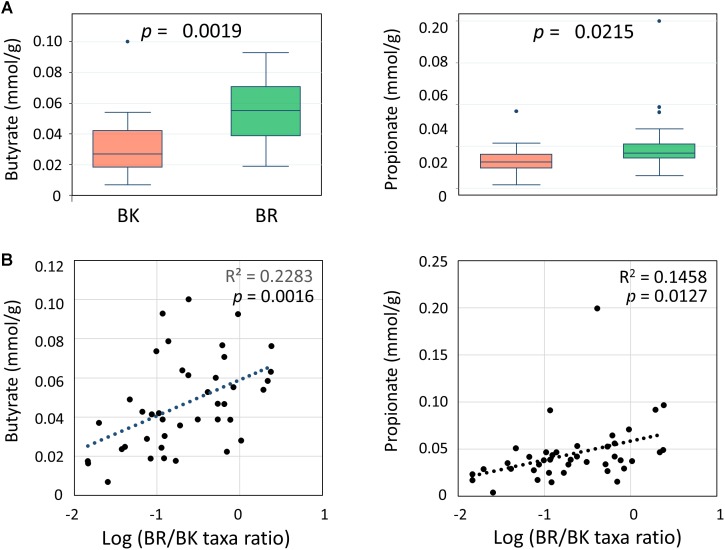
Comparison of the concentrations of fecal SCFAs between children in Bangkok and Buriram (A) and correlations with gut bacterial composition (B). The probability value (p) was calculated by Wilcoxon rank-sum test. Refer to Figure 1D for a description of the box plot. Correlation statistics were determined by Pearson’s correlation test. The post hoc analysis indicated the statistical powers for these Pearson’s correlation analyses to be 0.94 for butyrate and 0.82 for propionate.